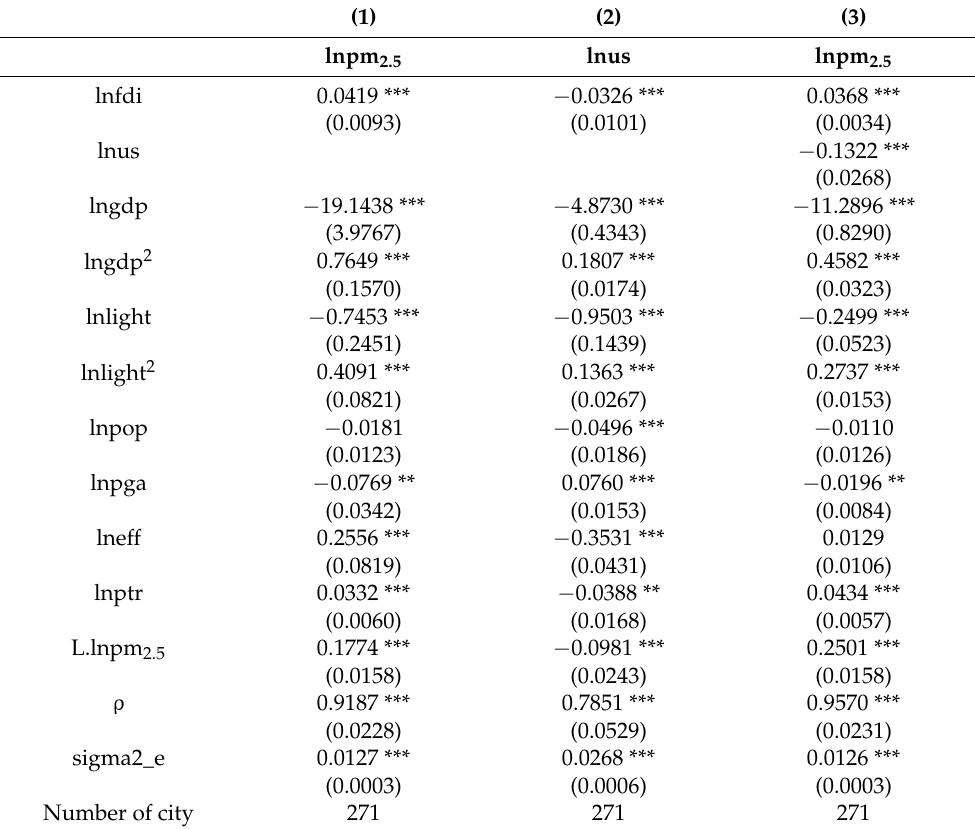
Table 8. Mediating effect of the industrial structure upgrading index.